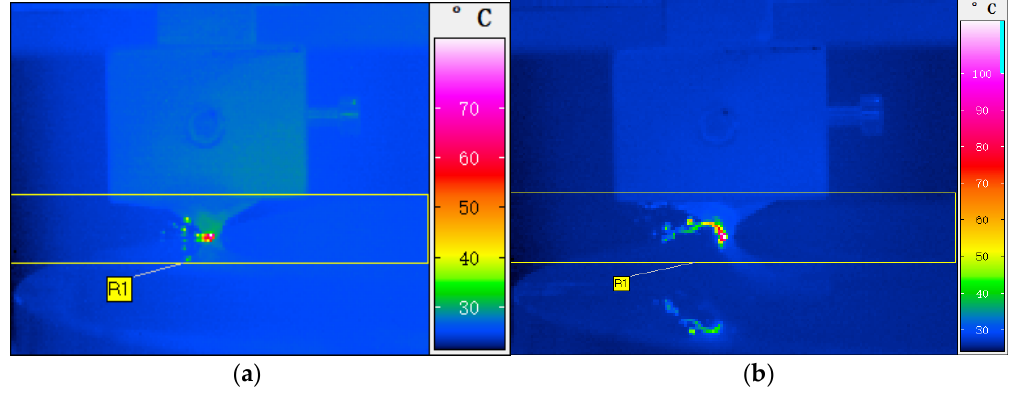
Figure 7. Cutting temperature images: ( a ) Cutting speed 5 m/s, ( b ) Cutting speed 10 m/s.